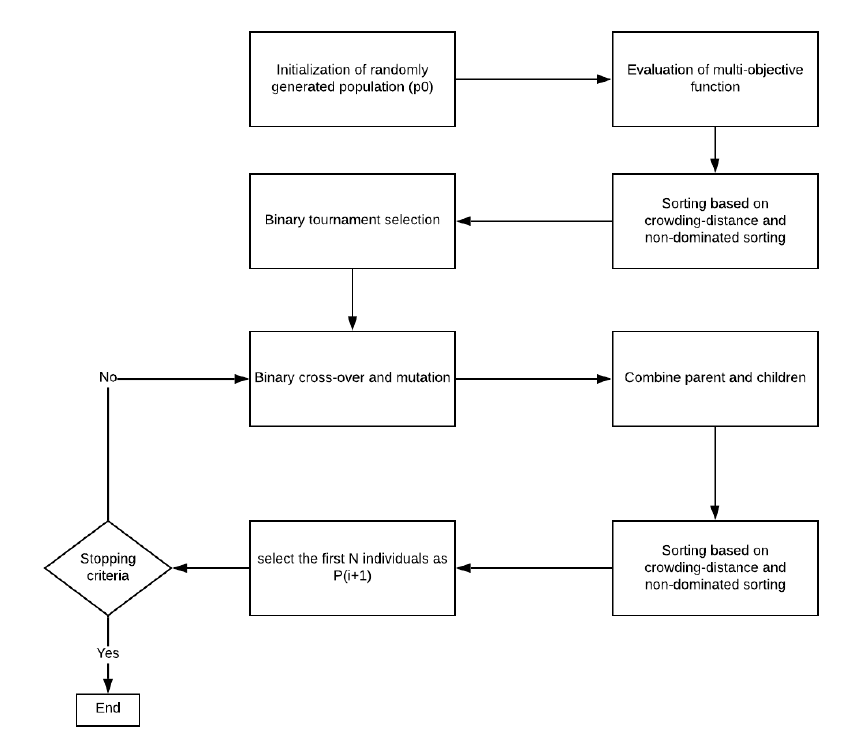
Figure 2. Traditional NSGAII